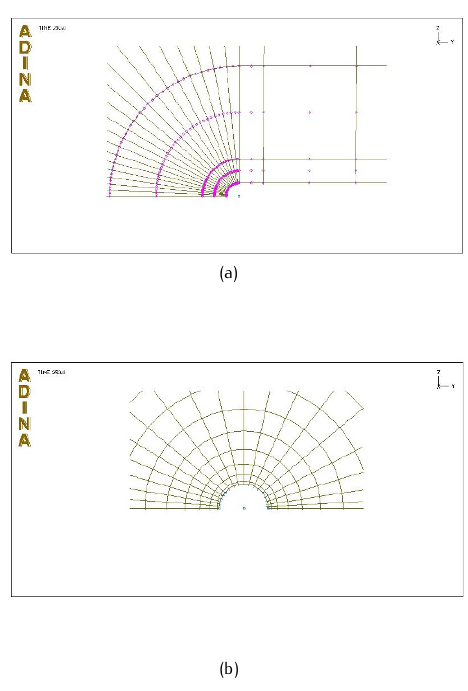
Figure 5. Two alternative crack tip models